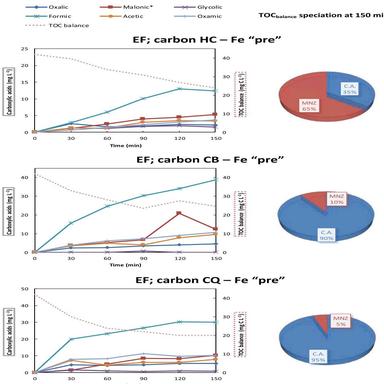
(left) Concentration of carboxylic acids and TOCbalance; (right) speciation of TOCbalance (fraction of unreacted pollutant and carboxylic acids) at 150 min in heterogeneous EF with the cathode materials loaded with iron by the "pre" methodology. Malonic and glyoxylic acids coeluted; calculations were done assigning the detected peak to malonic acid. Errors are below 3% in all measurements; error bars are not added to the plots for clarity.